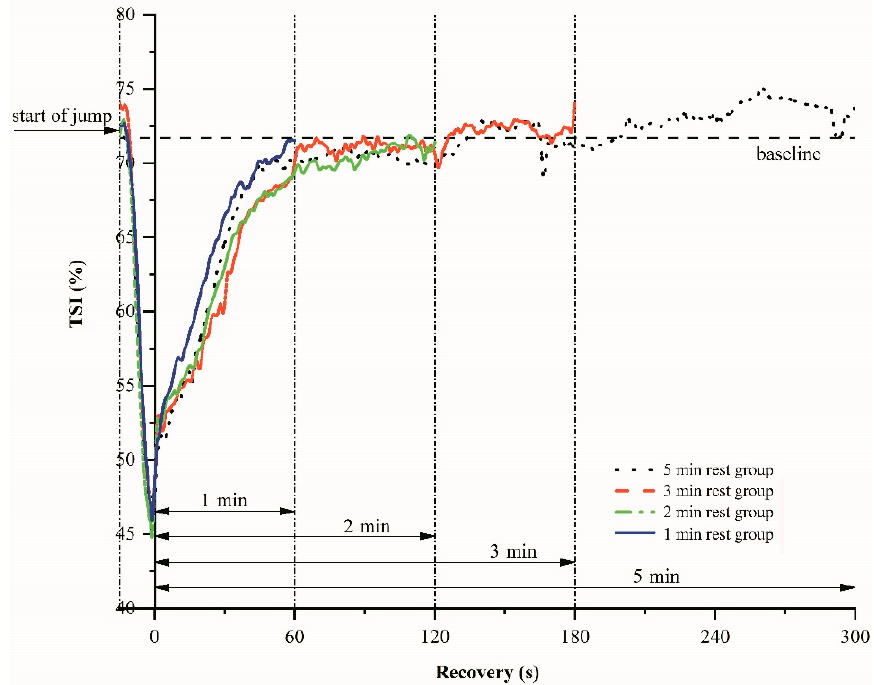
Figure 3. An example of the tissue saturation index (TSI) variations-time relations during plyometric exercise and various recovery periods.